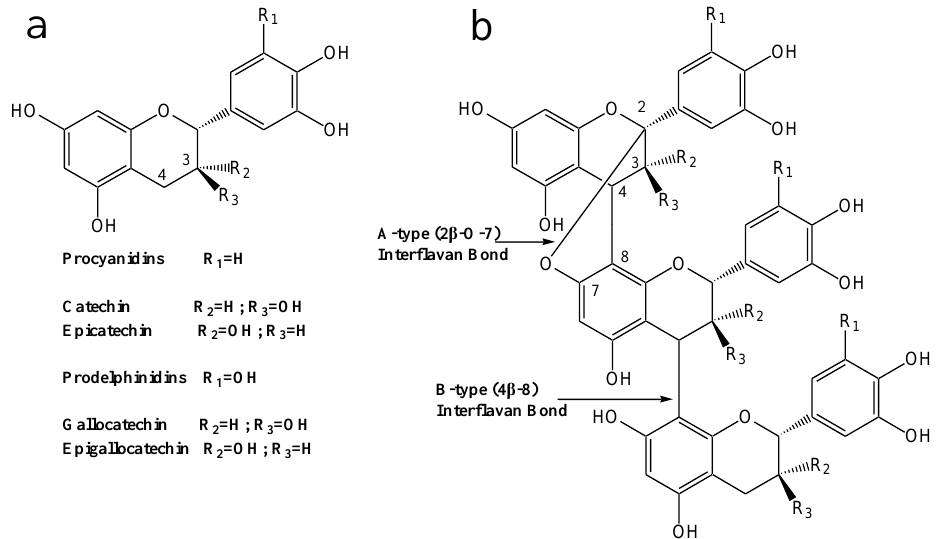
Figure 1. ( a ) Structures of the flavan-3-ol units. ( b ) Heteropolyflavan-3-ols from plum pericarp.